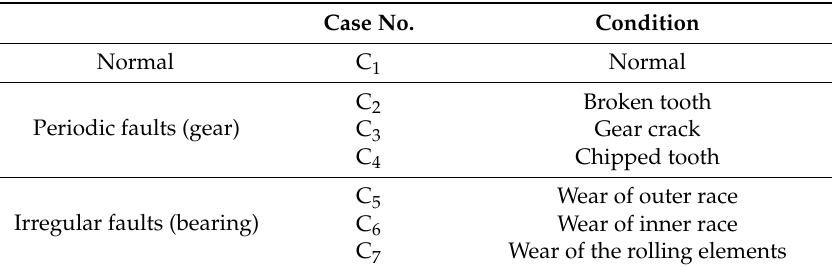
Table 2. The manually created six faults.